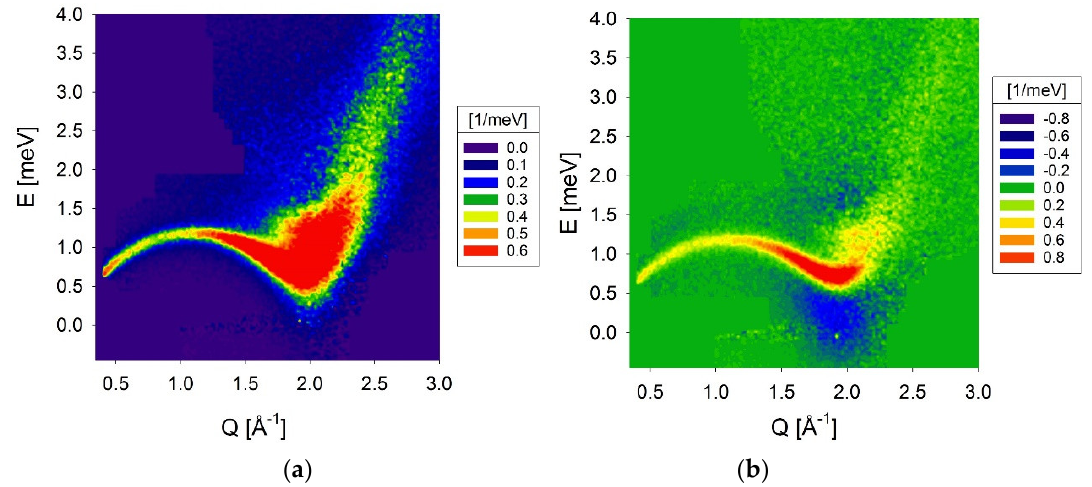
Figure 1. ( a ) Dynamics structure factor, S ( Q , E ), of 4 He liquid at T = 1.83 K (superfluid state) and ( b ) the difference in S ( Q , E ) between T = 1.83 K and 2.85 K (normal state) [29].